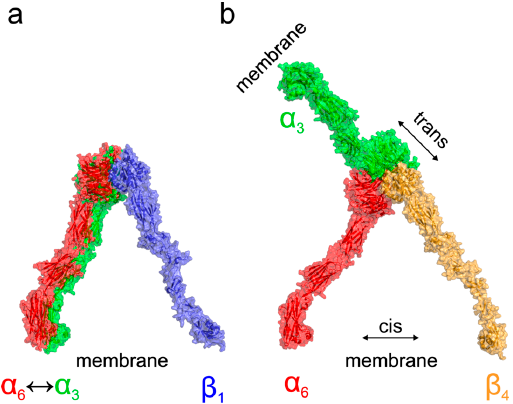
Figure 8. Model of activated states of α / β integrin heterodimers. A probable arrangement of integrin heterodimers in the open state was derived from the N-terminal domain complexes predicted by docking (see Figure 6) by a structural superposition of the existing crystal structure of α IIB β 3 in the open state (PDB ID 3fcu; [13]). The modelling suggests that while for the α 3 β 1, α 6 β 1 ( a ), and α 6 β 4 ( b ) the integrins are involved in a cis interaction adopting the expected conformation with the membrane proximal domains separated [34–37], the orientation of the α 3 β 4 N-terminal domains would lead to a complex with α and β subunits pointing in nearly opposite directions ( b ) supporting the possible trans interaction (see Supplementary Figure S2 for more details).